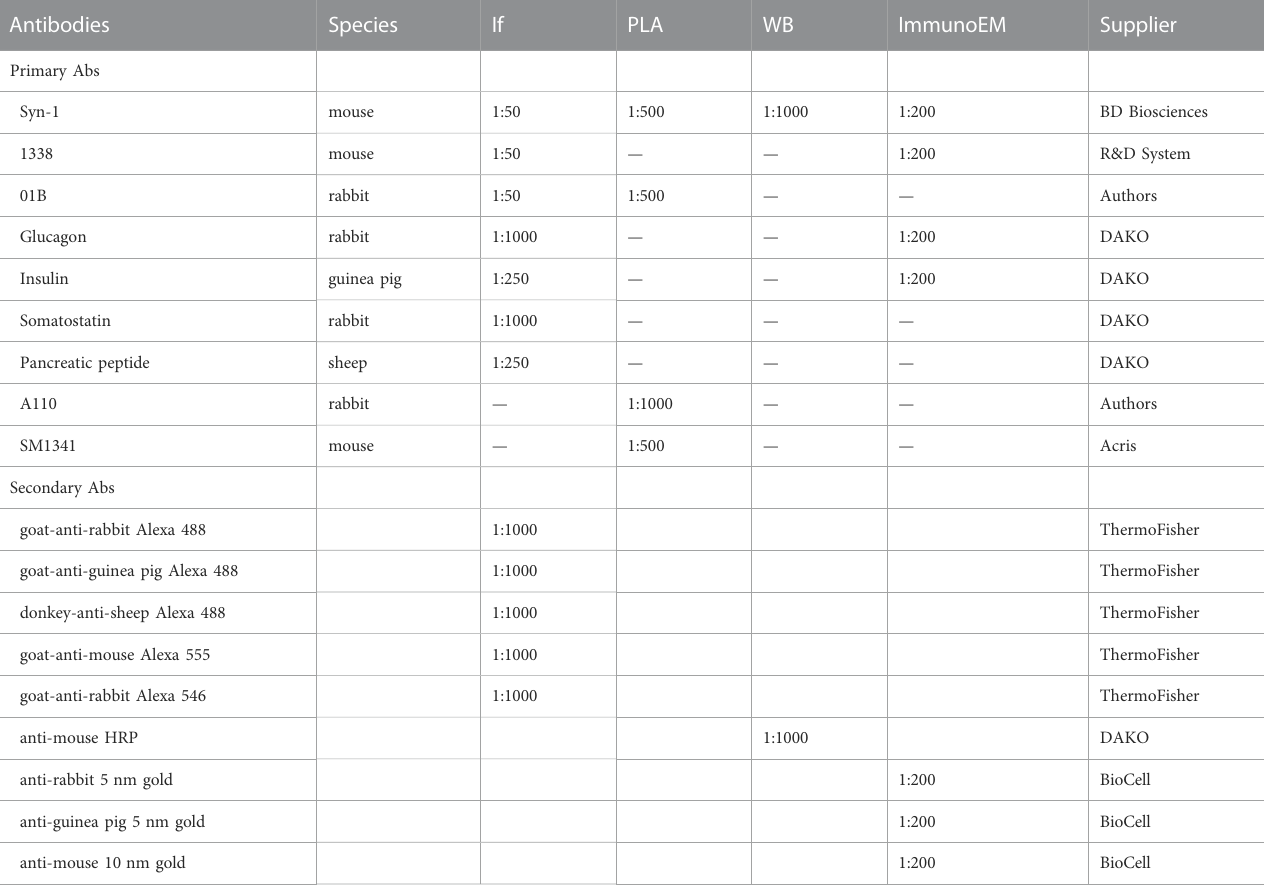
TABLE 1 Information on antibodies used for immuno fl uorescence, proximity ligation assay, Western blot and immunoEM. Antibodies Species